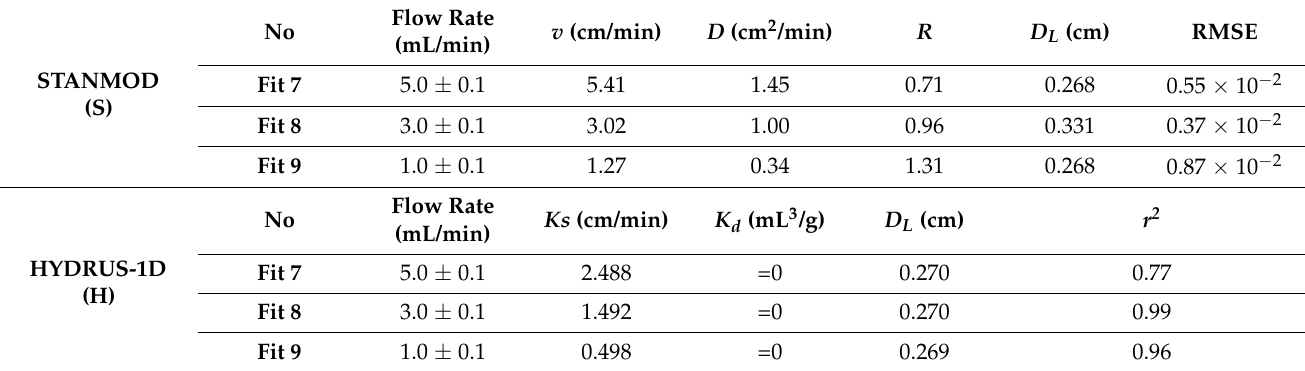
Table 5. The parameters for fitting I − BTCs (equilibrium